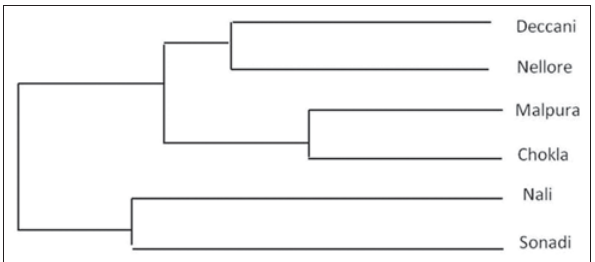
Figure-3: Dendrogram based on genetic distance of mitochondrial DNA cytochrome b region.